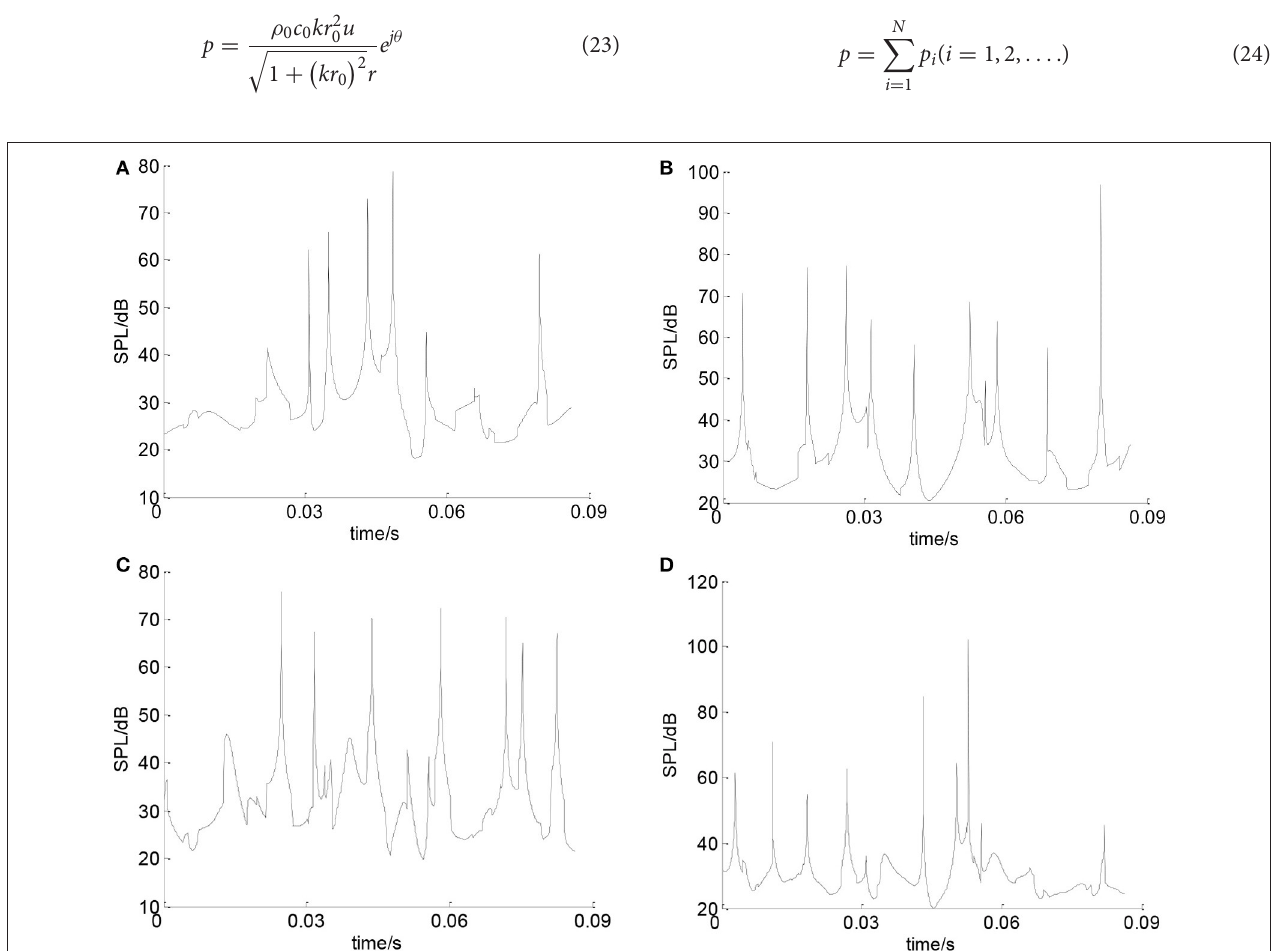
FIGURE 15 | (A) Bearing SPL with 5 waves. (B) Bearing SPL with 6 waves. (C) Bearing SPL with 8 waves. (D) Bearing SPL with 9 waves.